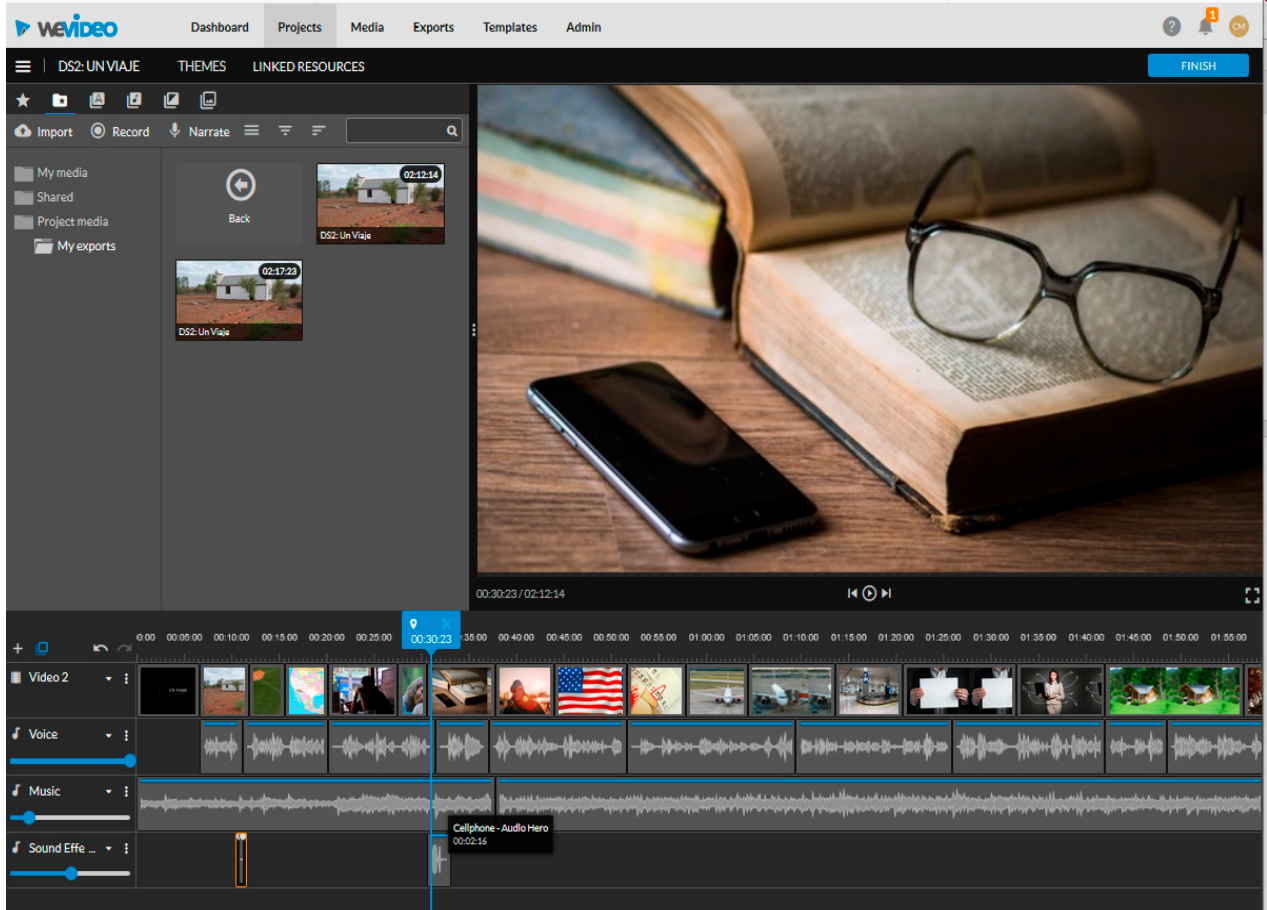
Figure 1. Screen capture of Abigail’s synesthesia in her individual DS in WeVideo. Like Abigail’s, most DSs contained four media tracks; although, some contained overlapping images rather than sound effects. For example, Liam and Luca (Pair 7) used an image of a single-family house with an image of U.S. dollar signs ($$) superimposed on the image, to reinforce the idea that owning a house is expensive in the United States. All DSs contained at least three separate tracks: one for images, voice-over recordings, and